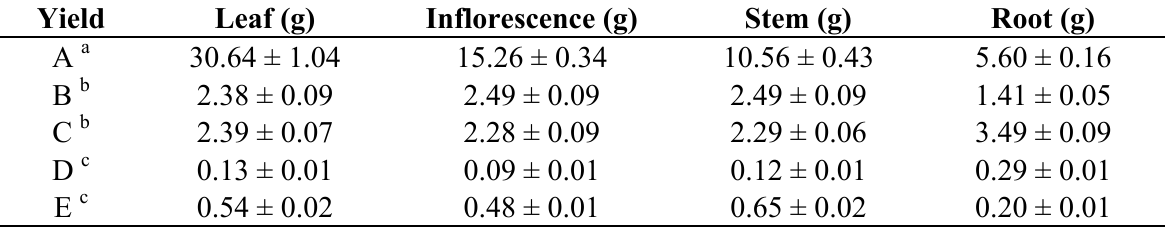
Table 1. Yields of extraction of E. ciliata in different plant